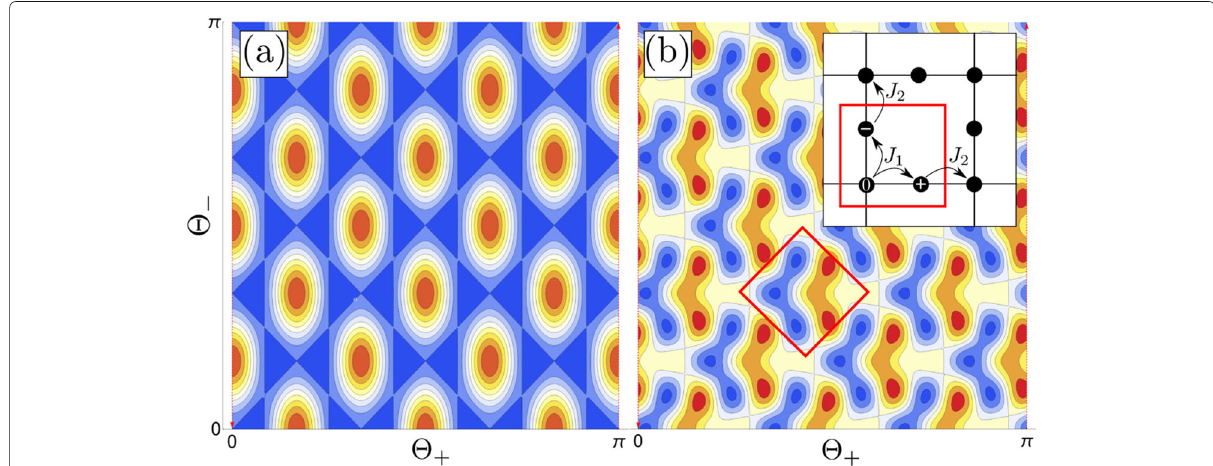
Fig. 9 a Honeycomb and b Lieb time lattices presented in the frame moving along a resonant trajectory. Atoms loaded to lattices fulfill the boundary conditions of the Möbius strip geometry, i.e., points { (cid:6) + = π , (cid:6) − } are identified with { (cid:6) + = 0, π − (cid:6) − } . Dark blue regions correspond to the lowest energies of a particle with negative effective mass. Reprinted from